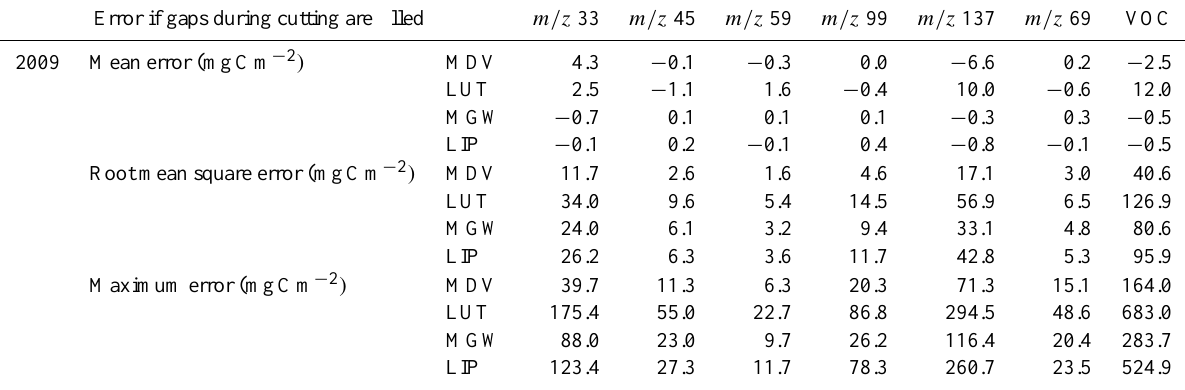
Table 2. Example of how mean, root mean square and maximal errors introduced by the application of the four gap-filling routines change if management events on the meadow were included for the error simulation in 2009. Error if gaps during cutting are filled m/z